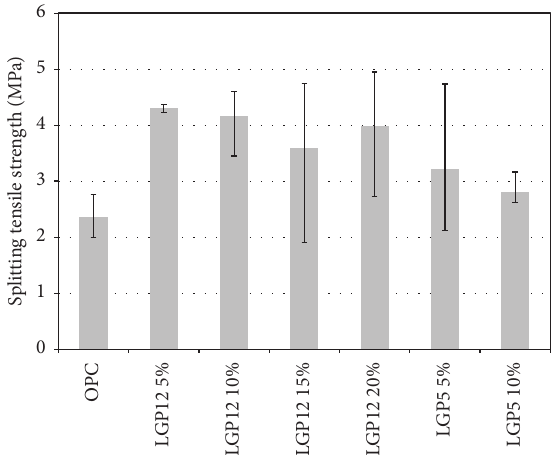
Figure 7: Comparison on splitting tensile strength of LGP concrete cylinders.